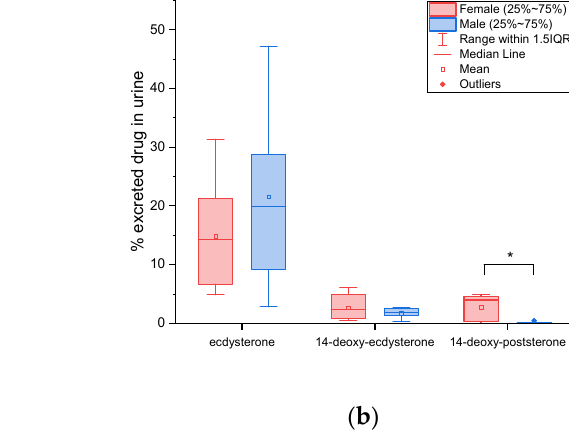
Table 6. Urinary pharmacokinetic parameters calculated as the mean of 12 subject ± standard deviation (SD), after admin- istration of a single dose of 50 mg of pure ecdysterone.